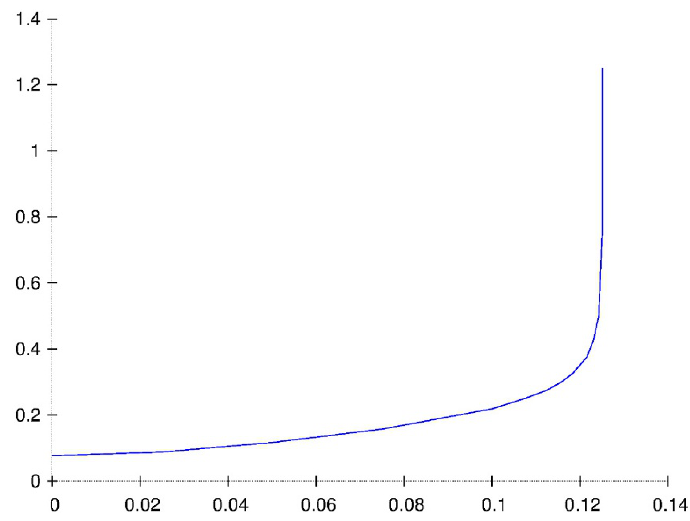
Figure 1 . The plot of the curve (cid:13) for n = 3 on which t is purely imaginary. The curve (cid:13) approaches the line Re( (cid:28) ) = 1 in the limit t ! 0. It terminates on the imaginary axis at which t diverges. 2 On the other hand, (2.29)